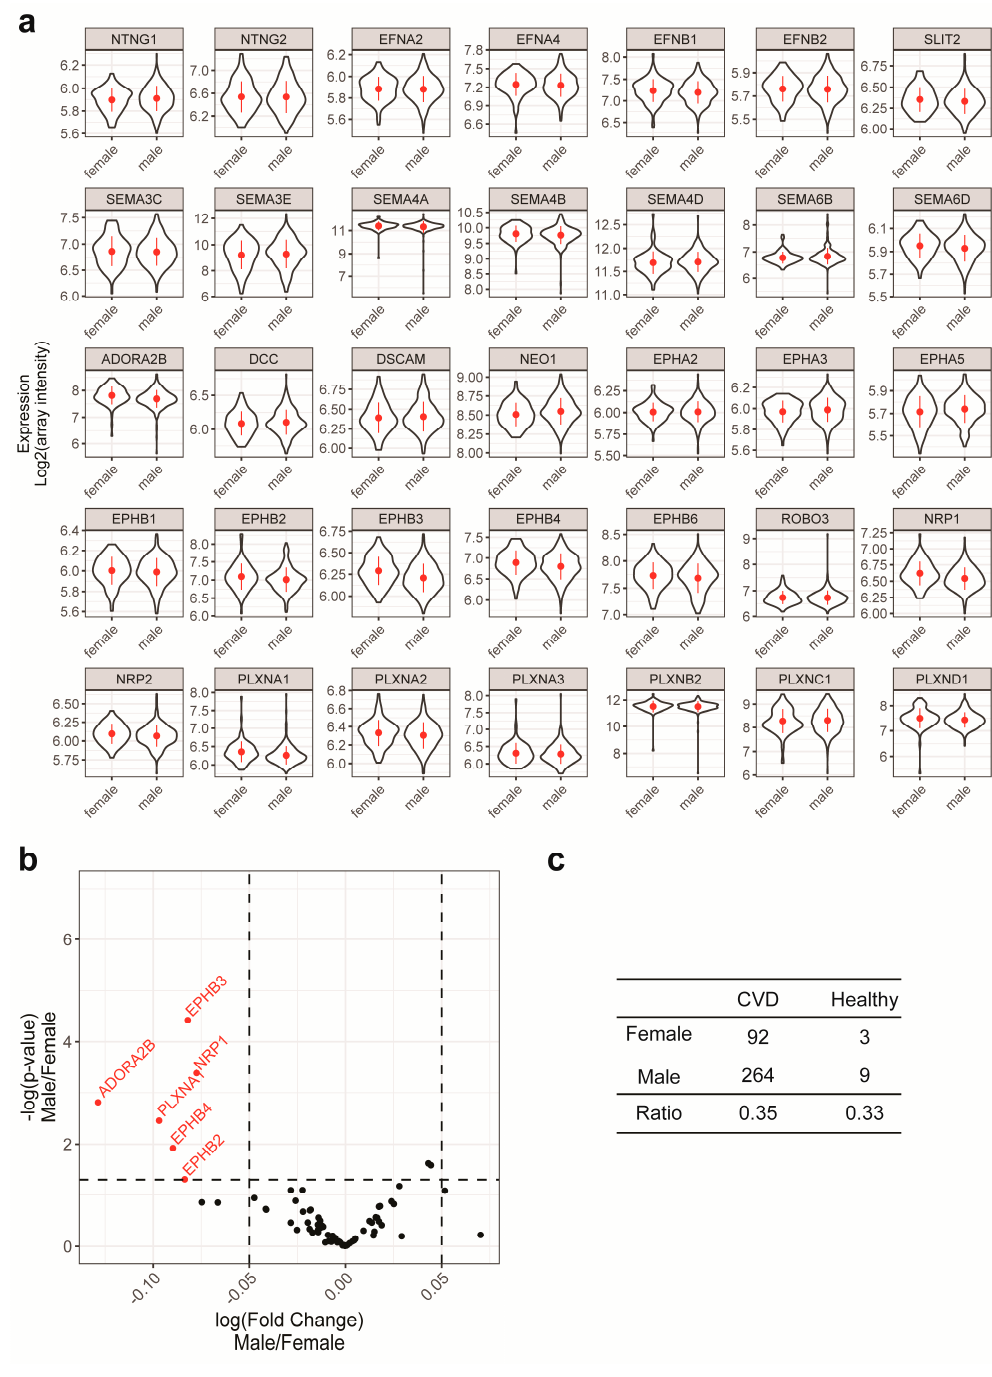
Figure 5. Inspection of the influence of sex as a potential confounding factor. ( a ) Violin plots to show the distribution of expressions of selected NGCs in males and females. To be noticed is that distributions of selected NGC expressions are similar between sexes. ( b ) A volcano plot was made showing the fold change and the significance of di ff erences in a 2 mean Student’s t -tests between NGC expressions in males and females. NGCs with significant di ff erences ( p < 0.05) were labeled with gene names and red color. ( c ) Contingency table showing that the ratio of sexes is not biased in relation to the